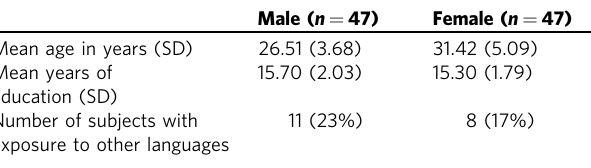
participants used in the connotative meaning